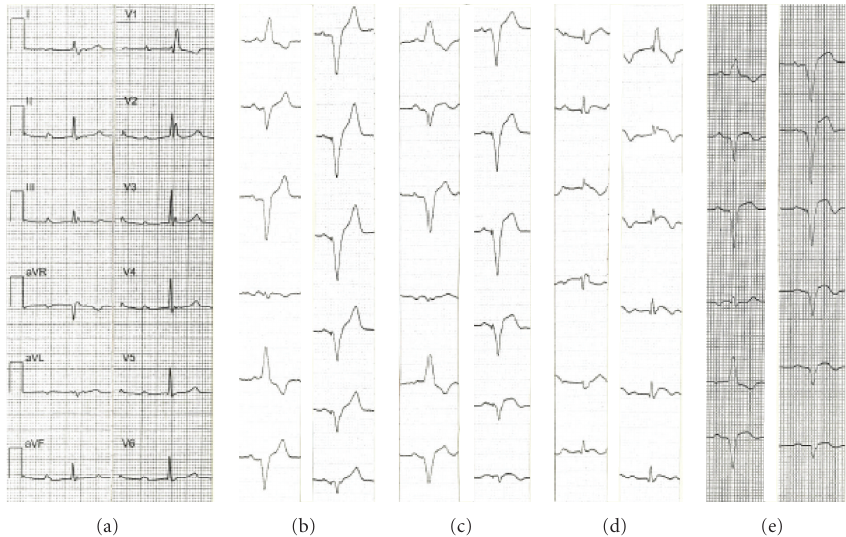
Figure 1: Evolving ECG aspect: (a) spontaneous sinus rhythm with first-degree AV block and right bundle branch block, (b) early postimplant with dual-chamber pacing, (c) dual-chamber pacing with ST segment elevation in inferior and anterior leads, (d) spontaneous rhythm with PM inhibited and ST segment elevation in inferior and anterior leads, and (e) dual-chamber pacing at discharge with evolving repolarization abnormalities.